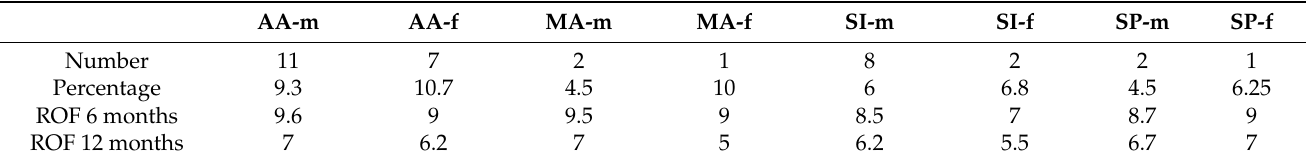
Figure 2. Rating of Fatigue (ROF) analysis. In almost all pairwise comparisons, the values at 12 months are markedly lower than those at 6 months. Considering that assumption checks were violated, RM-ANOVA is not allowed. The descriptions show that the reductions at 12 months are less marked in the SP group (mean difference of 3.6 for females and 3.9 for males) than in the AA (mean difference of 5.2 for females and 5.3 for males), MA (mean difference of 4.7 for females and 6 for males), and SI groups (mean difference of 5.4 for females and 5.7 for males). Interestingly, less than 10% of the statistical sample, with no variation between genders and categories, had persistent muscle fatigue symptoms greater than or equal to 5 as ROF, one year after the end of the acute disease. Mild impairment of cognitive processes and lack of restorative sleep was also present in this subpopulation (Table 3). Table 3. Percentage, by category, of the simultaneous presence of mild cognitive impairment, poor sleep quality, and persistent muscle fatigue one year from the end of COVID-19